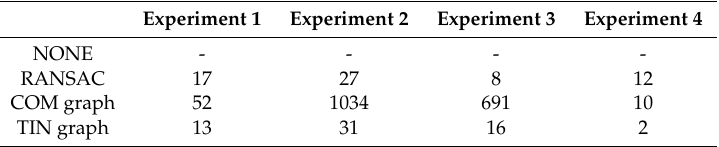
Table 3. Experimental results of computation time t